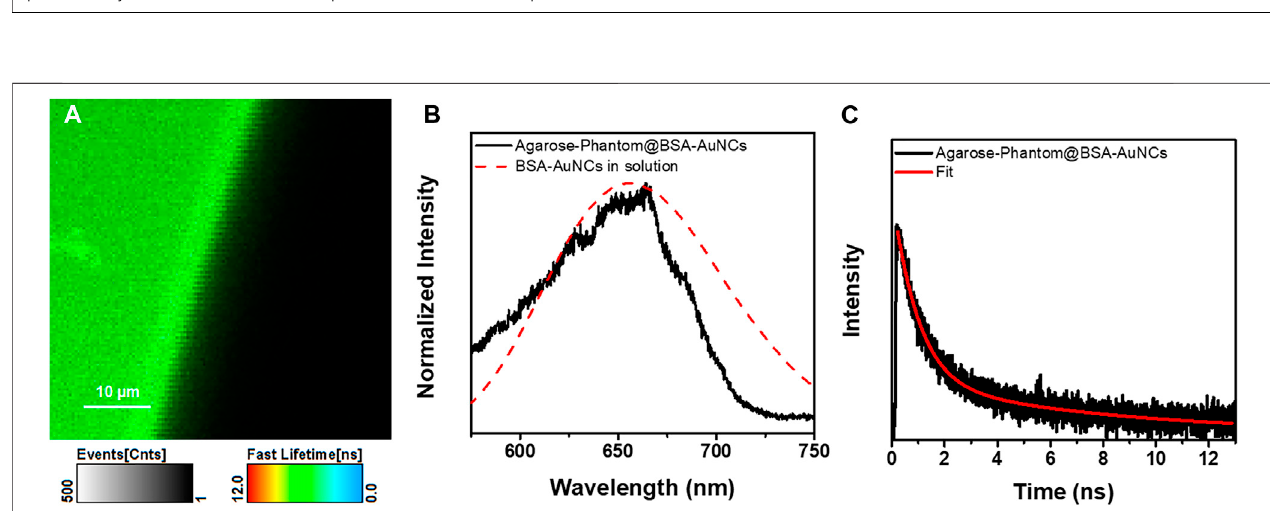
FIGURE 6 | (A) TPE FLIM image (the image was recorded at a resolution of 200 × 200 px with an imaging speed of 105 s) and (B) the corresponding emission spectrum of the Agarose-Phantom@BSA-AuNCs (black line) obtained under excitation at 810 nm (20 mW) and of BSA-AuNCs (dashed red line) in solution at 405 nm excitation. (C) TPE lifetime decay curve obtained for Agarose-Phantom@BSA-AuNCs at 810 nm excitation (20 mW). The intensity of the lifetime decay is presented in a logarithmic scale.